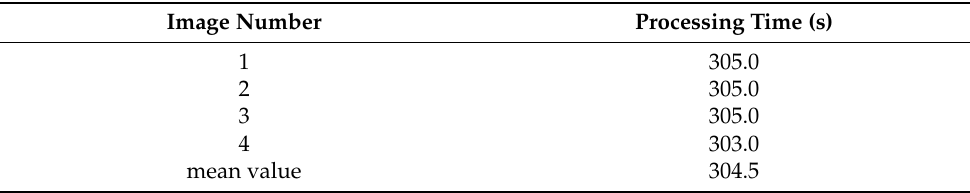
Table 2. Calculation times of template